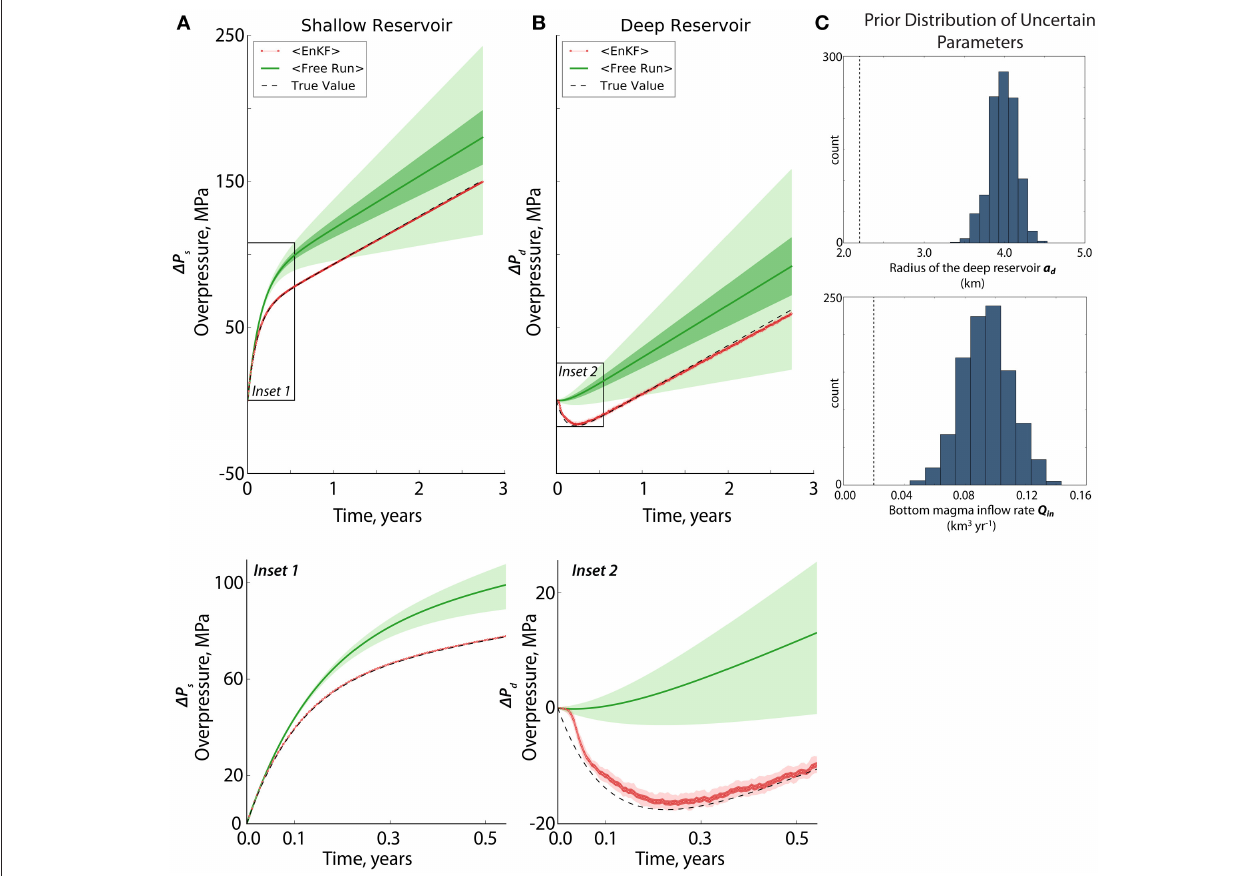
FIGURE 5 | The evolution of the overpressures after performing the state estimation (A,B) given that the initial ensemble of the uncertain parameters (C) are Gaussian, not centered on their true values (black broken lines). The insets provide a magnified image of the overpressures at the beginning of the assimilation. In (A,B) as well as in the insets, the black broken line represents the true value of the overpressures; the green ones represent the result of the free run where the green solid line is the mean, the dark green fill is the spread (1 σ ) and the light green fill covers the full extent of the ensemble (i.e., [min, max]); the red ones represent the result of EnKF where the red solid line is the mean, the dark red fill is the spread (1 σ ) and the light red is the full extent of the ensemble. Notice that the spread of the ensemble is very narrow for the assimilation case ( 10 4 –10 6 ∼